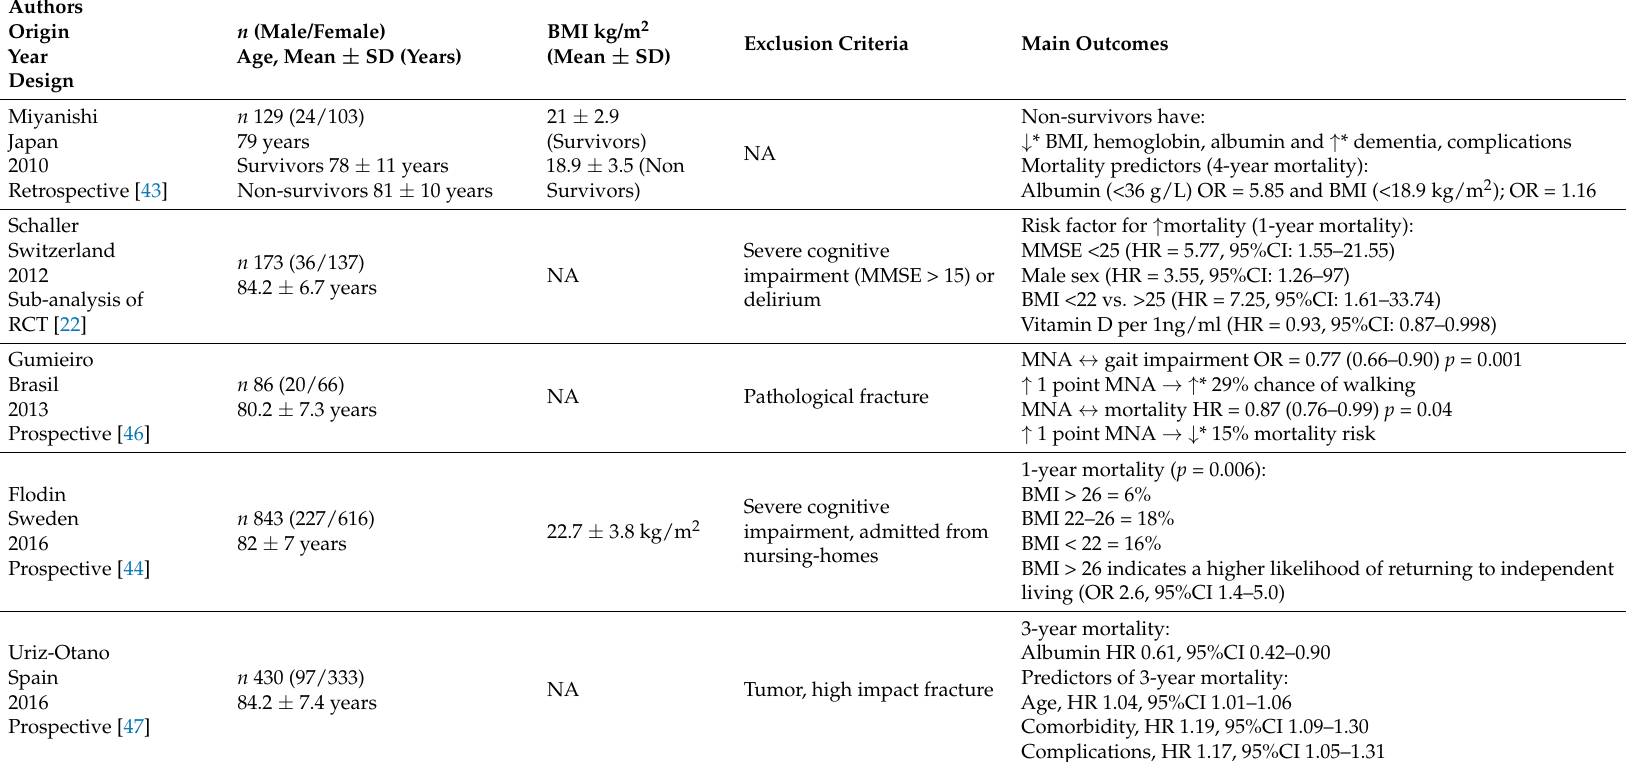
Table 4. Relationship between nutritional status and